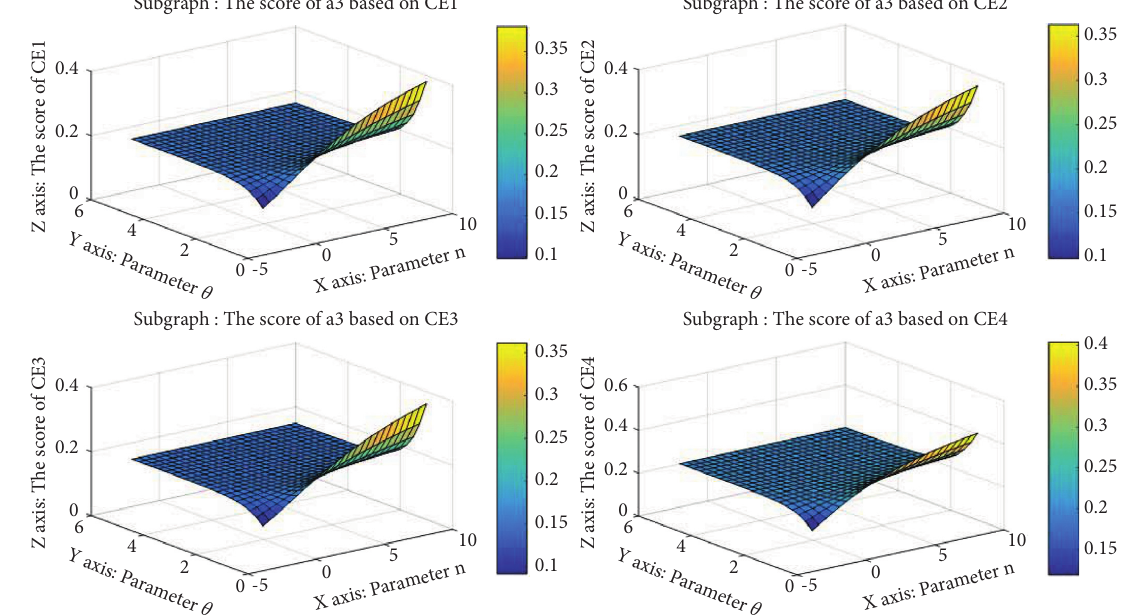
Figure 4: Score of alternative a